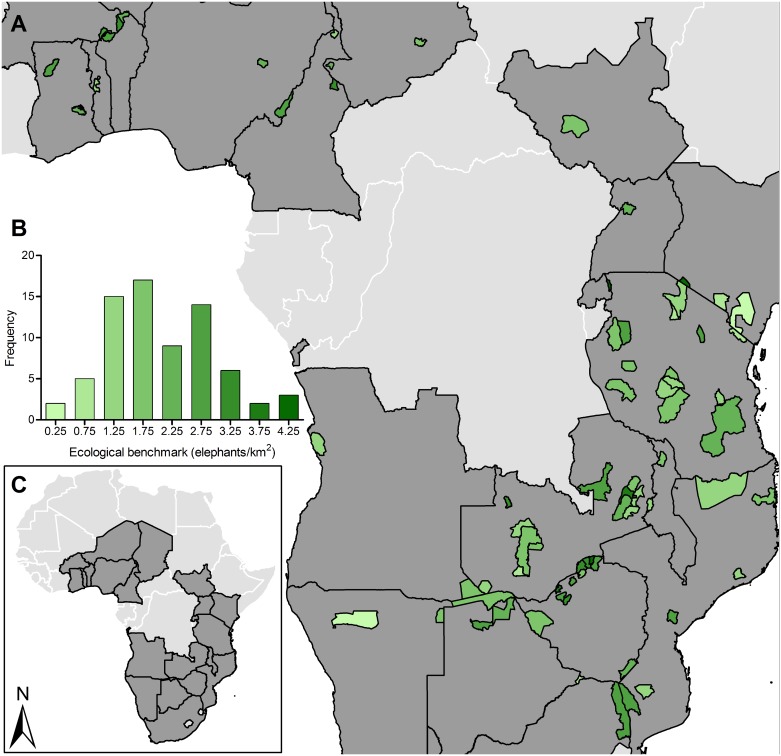
Predicted ecological benchmark density for savanna elephant populations across 73 protected areas differed according to EVI and water availability given minimized poaching.(A) Green fill color indicates predicted ecological benchmark density as shown in (B) the frequency distribution where densities on the x-axis represent bin centers. (C) Twenty-one countries are covered by protected areas in this assessment. See Figure E and Table F in S1 File for the 95% prediction intervals of predicted ecological benchmarks.